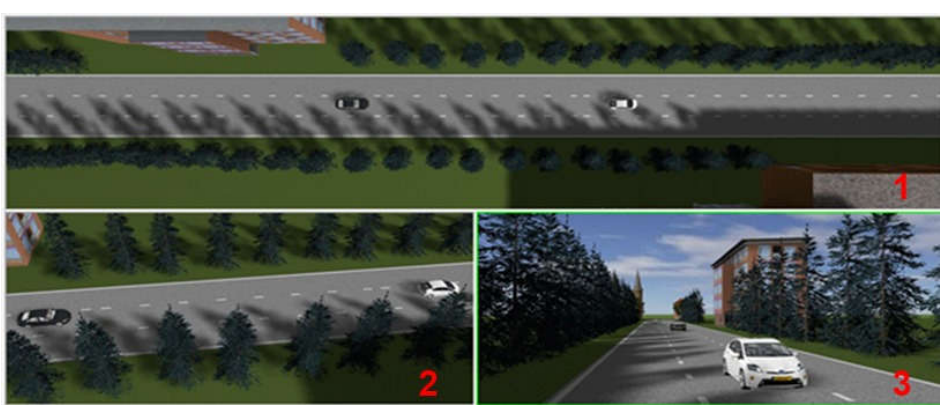
Figure 7. Viewpoints on